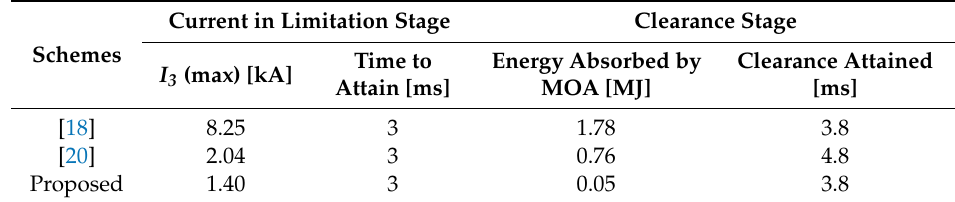
Table 3. Performance evaluation chart for fault current limitation and clearance